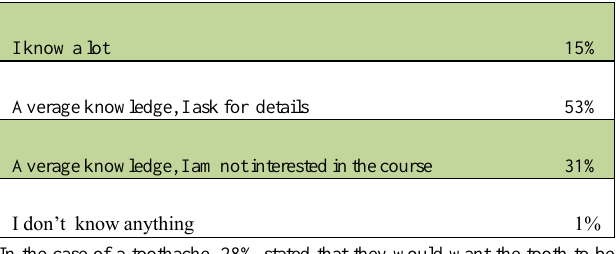
Table 3. Self-evaluation of patients’ knowledge on the endodontic treatment.